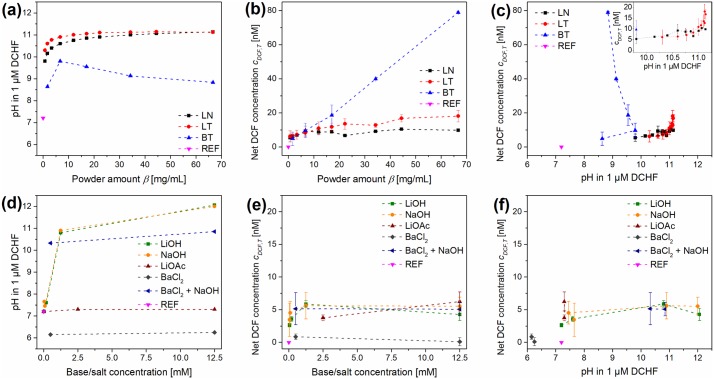
Results with the DCHF-based reaction protocol (cDCHF,0 = 1 μM) of the DCF assay for different pyroelectric powders, bases/salts and reference experiments (REF) after thermal treatment.pH-increase with increasing powder amount β (a) or base/salt concentration (d). Measured net DCF concentration cDCF,T with increasing β (b) or base/salt concentration (e). Combination of measured pH and cDCF,T for powders (c) and bases/salts (f). LN: LiNbO3, LT: LiTaO3, BT: BaTiO3, DCF: dichlorofluorescein, DCHF: dichlorodihydrofluorescein.